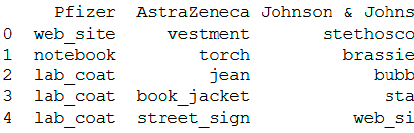
Figure 6. Predicted image classes.